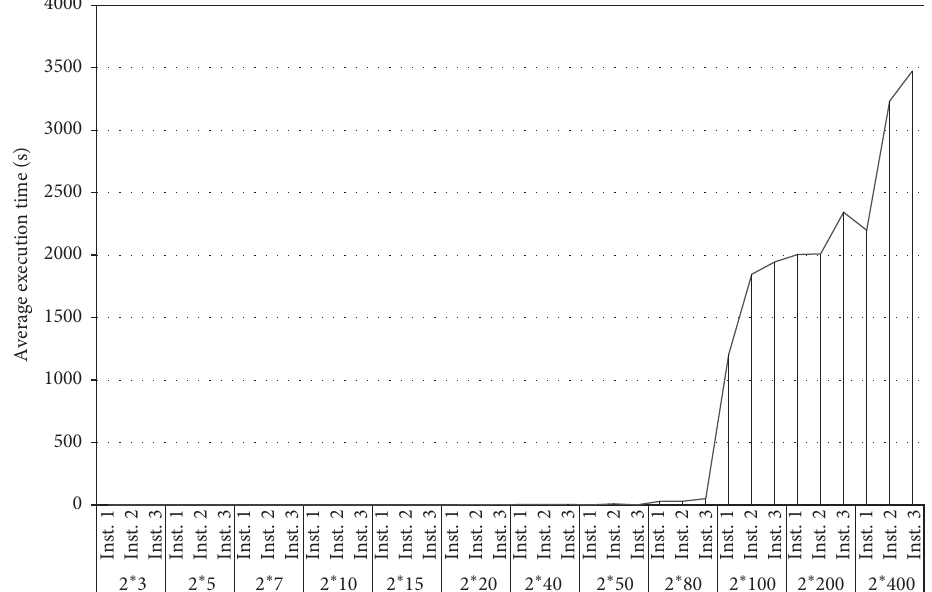
Figure 1: Average execution times for different